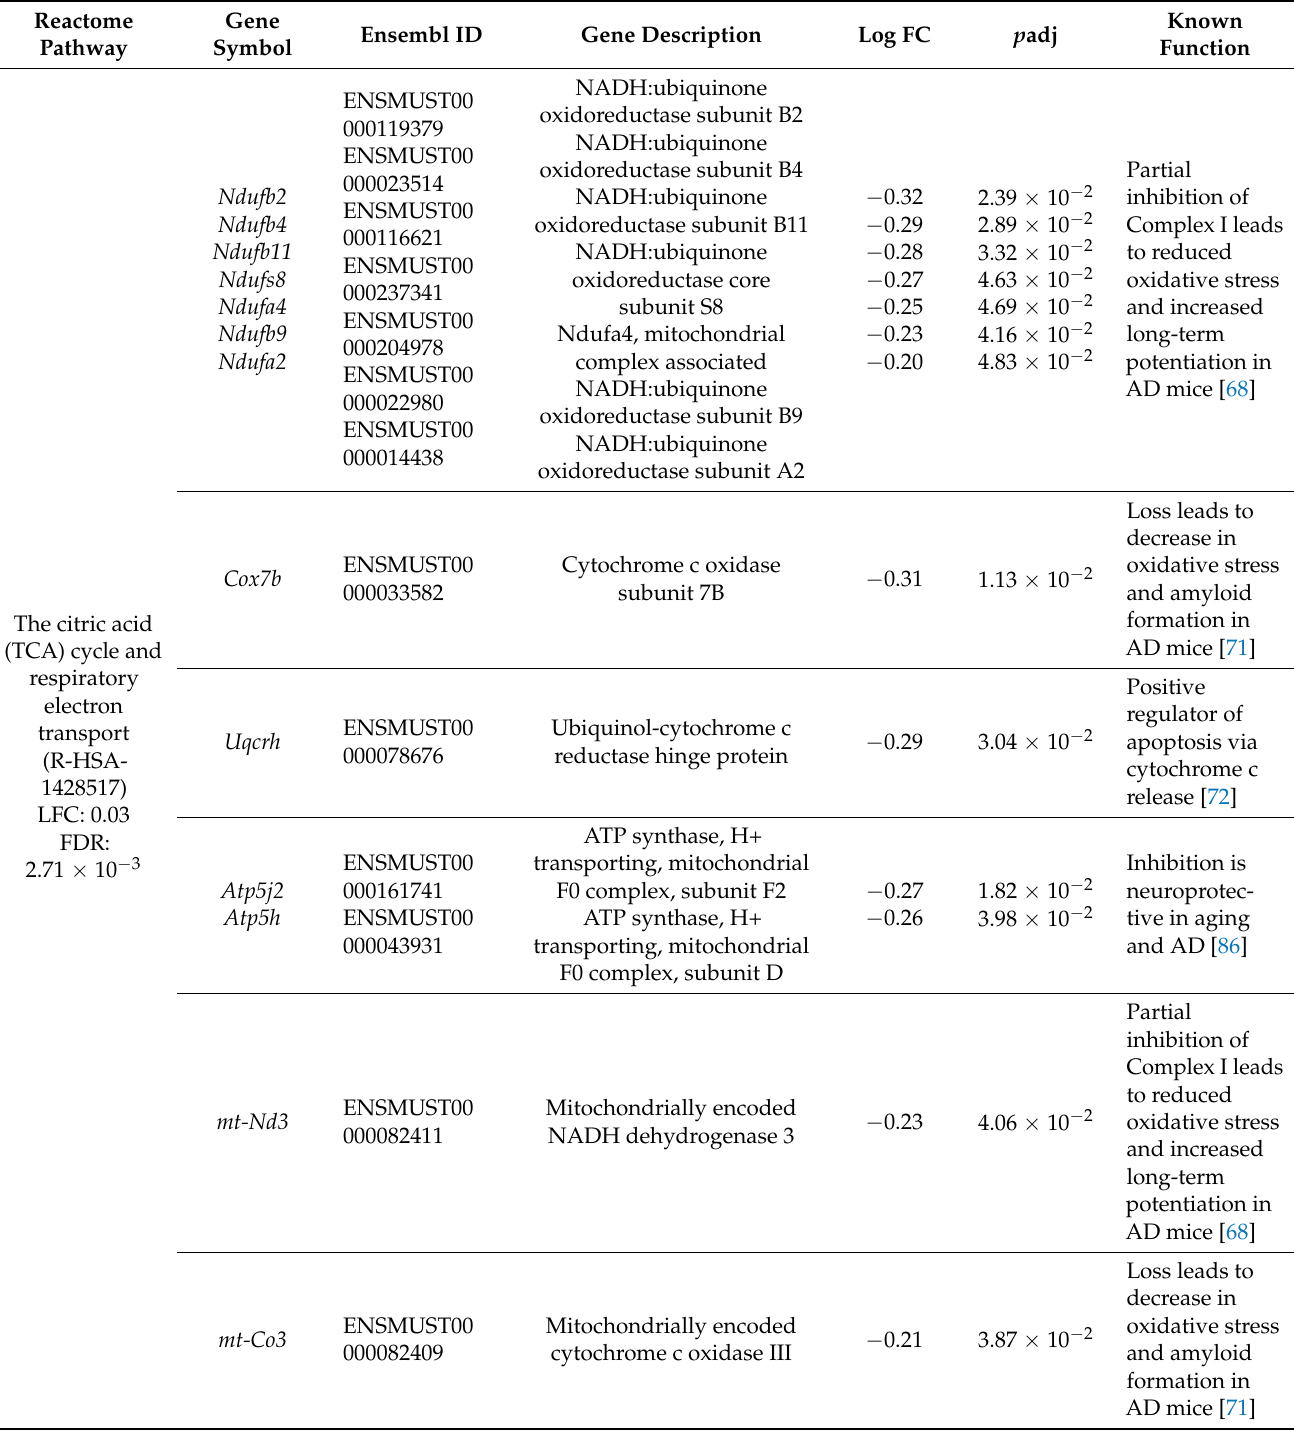
Table 3. Differentially Expressed Pathways in HFD-fed AKO Compared to HFD-fed WT Mice. FDR ≤ 0.01. Pathway name, stable identifier, log fold change (log2), and false discovery rate for each pathway are displayed. Within each pathway, gene ID, Ensembl ID, gene description, log fold change (log2), log10 adjusted p -value, and relevant known function are